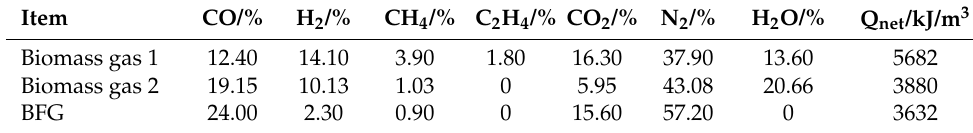
Table 3. The properties of two biomass-produced gases and a BFG.